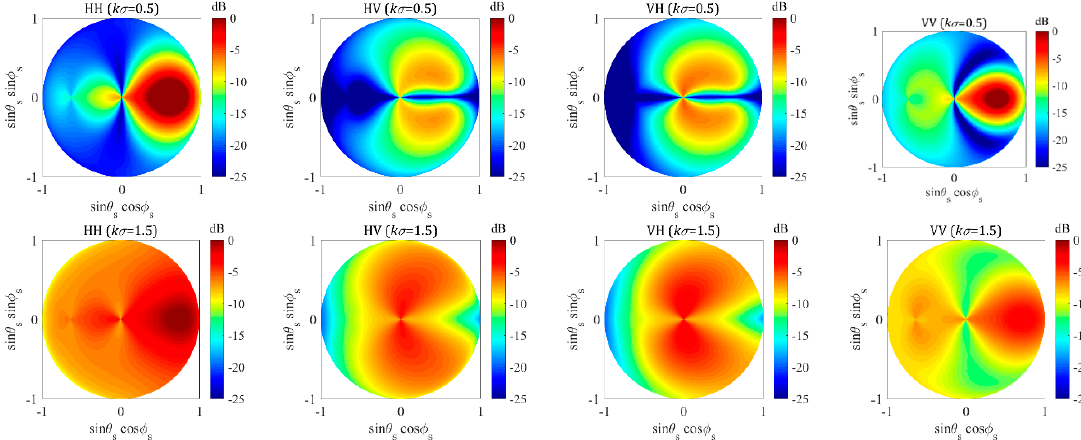
Figure 5. Hemispherical plots of polarized bistatic scattering coefficients HH, HV, VH, and VV, with exponentially correlated surface θ i = 40 ◦ , kl = 5.0, m v = 20%. Top row: k σ = 0.5. Bottom row: k σ =